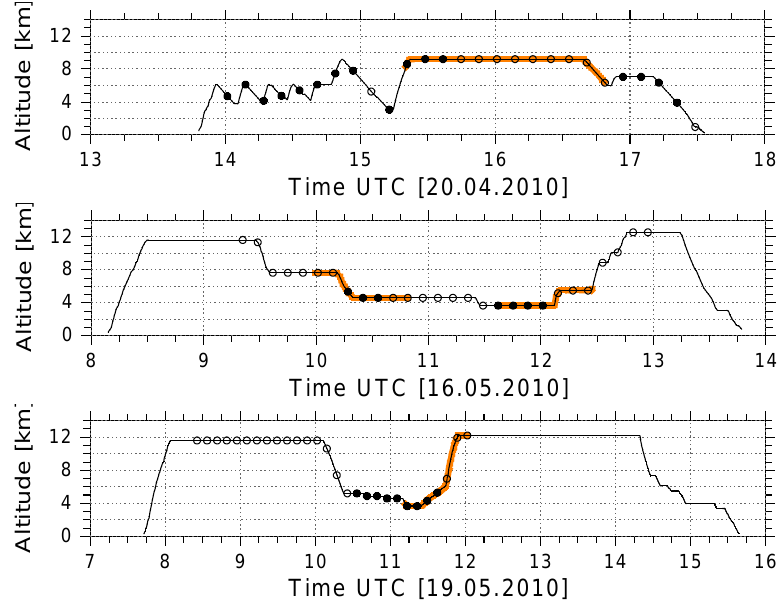
Fig. 4. Altitude profiles of the CARIBIC flights on 20 April 2010 (upper panel), 16 May 2010 (middle panel) and 19 May 2010 (lower panel). All altitudes are pressure altitude according to the International Standard Atmosphere (ISA). The whole air samples and the aerosol impactor samples are indicated in the same way as in Fig.